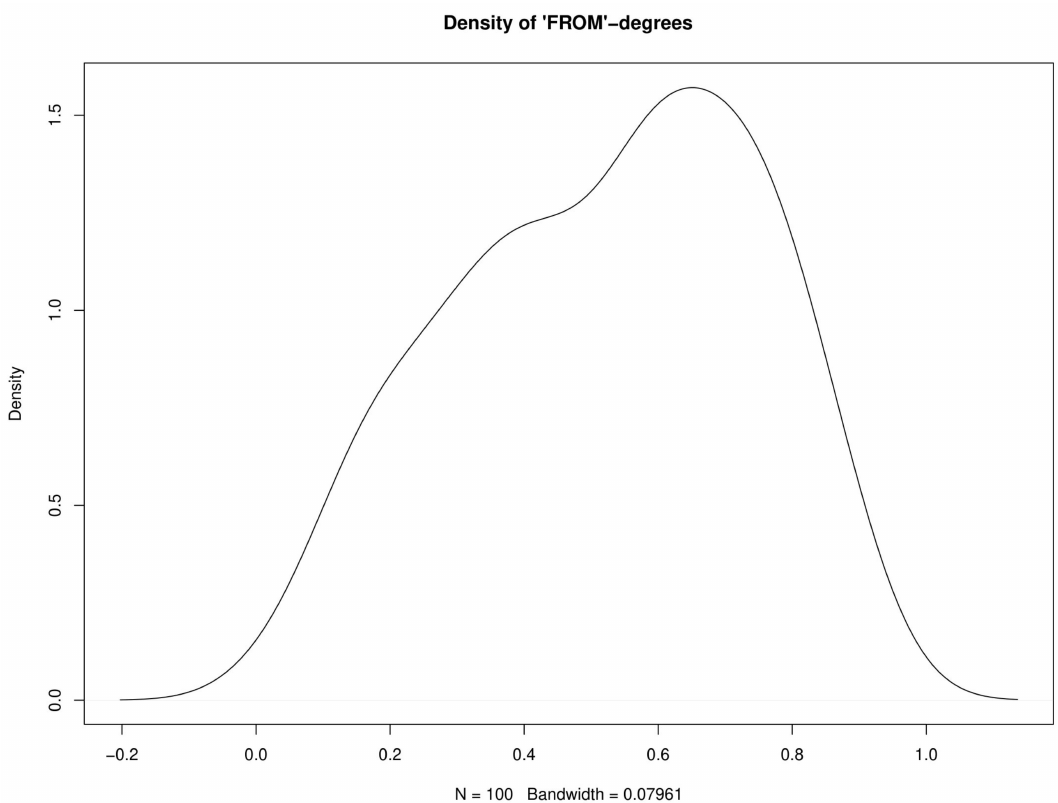
Figure 8. Kernel estimate of the density of